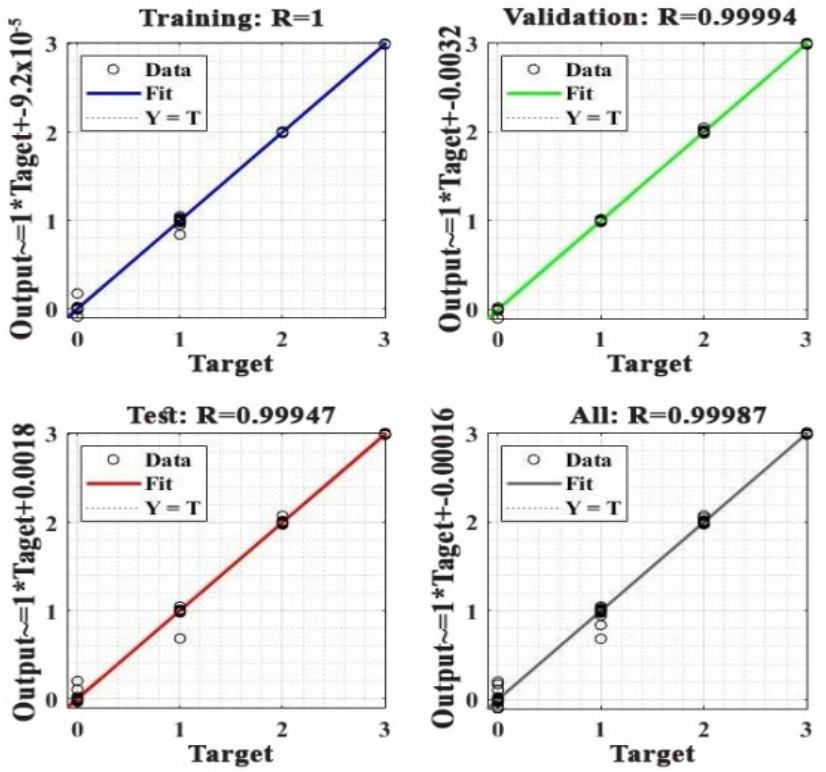
Figure 14. Regression parameter R for 2-FAL Analysis FFNN.